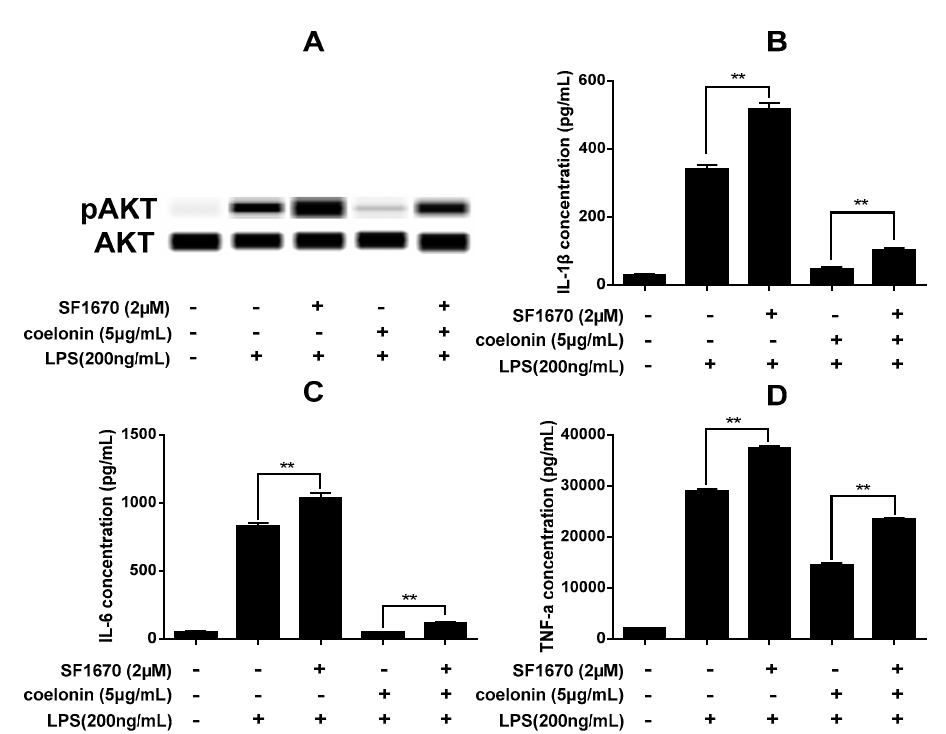
Figure 7. ( A ) Western blotting result of pAKT. RAW264.7 cells were incubated with solvent or 200 ng / mL LPS for 30 min in the absence or presence 5 µ g / mL of coelonin or 2 µ M of the PTEN inhibitor SF1670 or 2 µ M of SF1670 combined with 5 µ g / mL of coelonin. Then total cellular protein was extracted and analyzed by a simple western immunoblotting technique on a Peggy Sue system. ( B – D ) E ff ect of PTEN inhibitor SF1670 on anti-inflammatory activity of coelonin. RAW264.7 cells were incubated with solvent or 200 ng / mL LPS for 12 h in the absence or presence 2 µ M of the PTEN inhibitor SF1670 or 5 µ g / mL of coelonin or 2 µ M of SF1670 combined with 5 µ g / mL of coelonin. Culture supernatants was collected for IL-1 β , IL-6 and TNF- α detection by CBA method. Data are expressed as mean ± SD ( n = 6). ** p < 0.01.